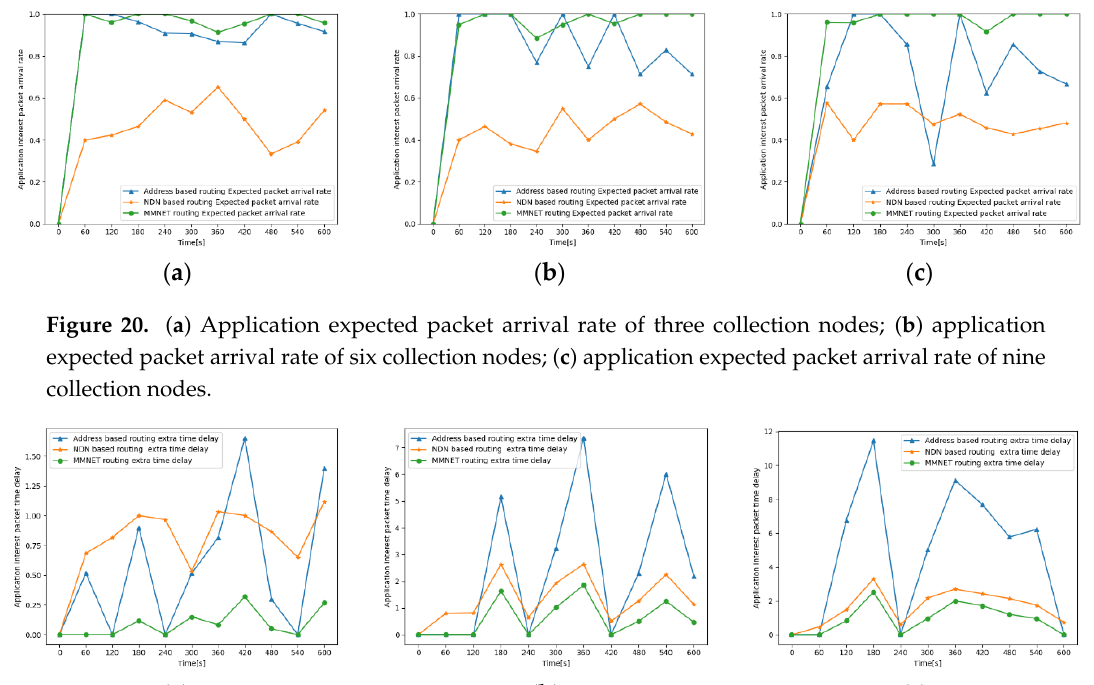
Figure 20. ( a ) Application expected packet arrival rate of three collection nodes; ( b ) application expected packet arrival rate of six collection nodes; ( c ) application expected packet arrival rate of nine collection nodes.